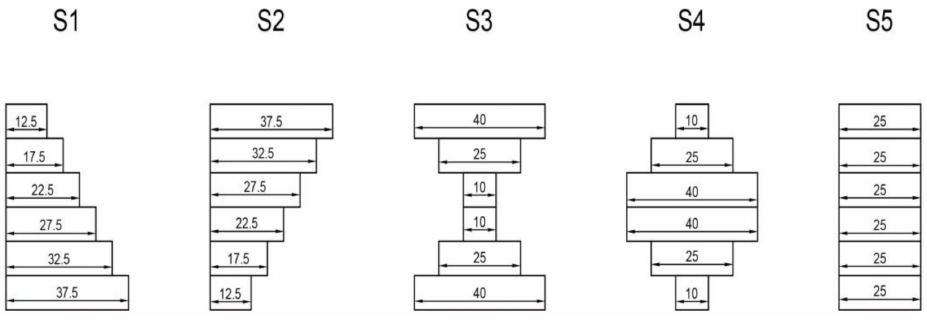
Figure 7. Five OCA layer profiles (units shown in µ